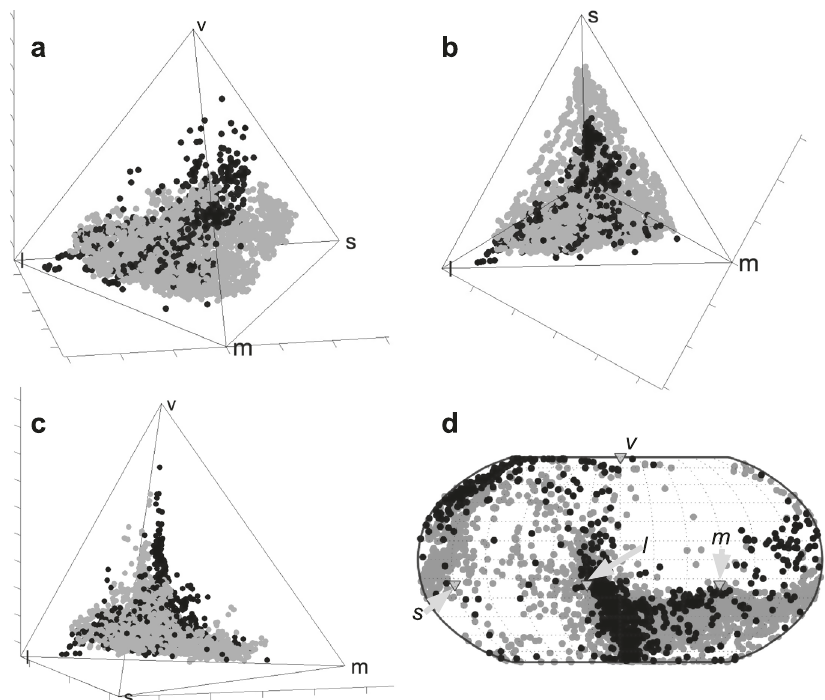
Fig. 2 The contribution of hummingbird spectra to the known avian color gamut. a – c The distribution of color points of our hummingbird data (gray) and Stoddard and Prum ’ s (2011) data for all birds (black) in an avian VS color space viewed from different directions: a standard angle, b a top-down view displaying the expansion of hummingbird plumage colors in s -, m -, and l - dimensions, and c a view toward the l-m edge from slightly below displaying the expansion of hummingbird colors toward the s-v-l face of the color space, and the paucity of color points in the m + uv/v region of the color space. d Corresponding Robinson projection of color point hues showing the expansion of hummingbird colors in terms of hues, especially in the s − , s + m − , s + l − , and s + l + uv/v − regions.